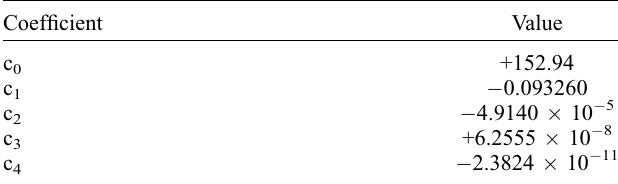
Table 5. Coef fi cients for wavelength calibration estimated from observation of Earth ’ s geocorona on 29 November, 2013.